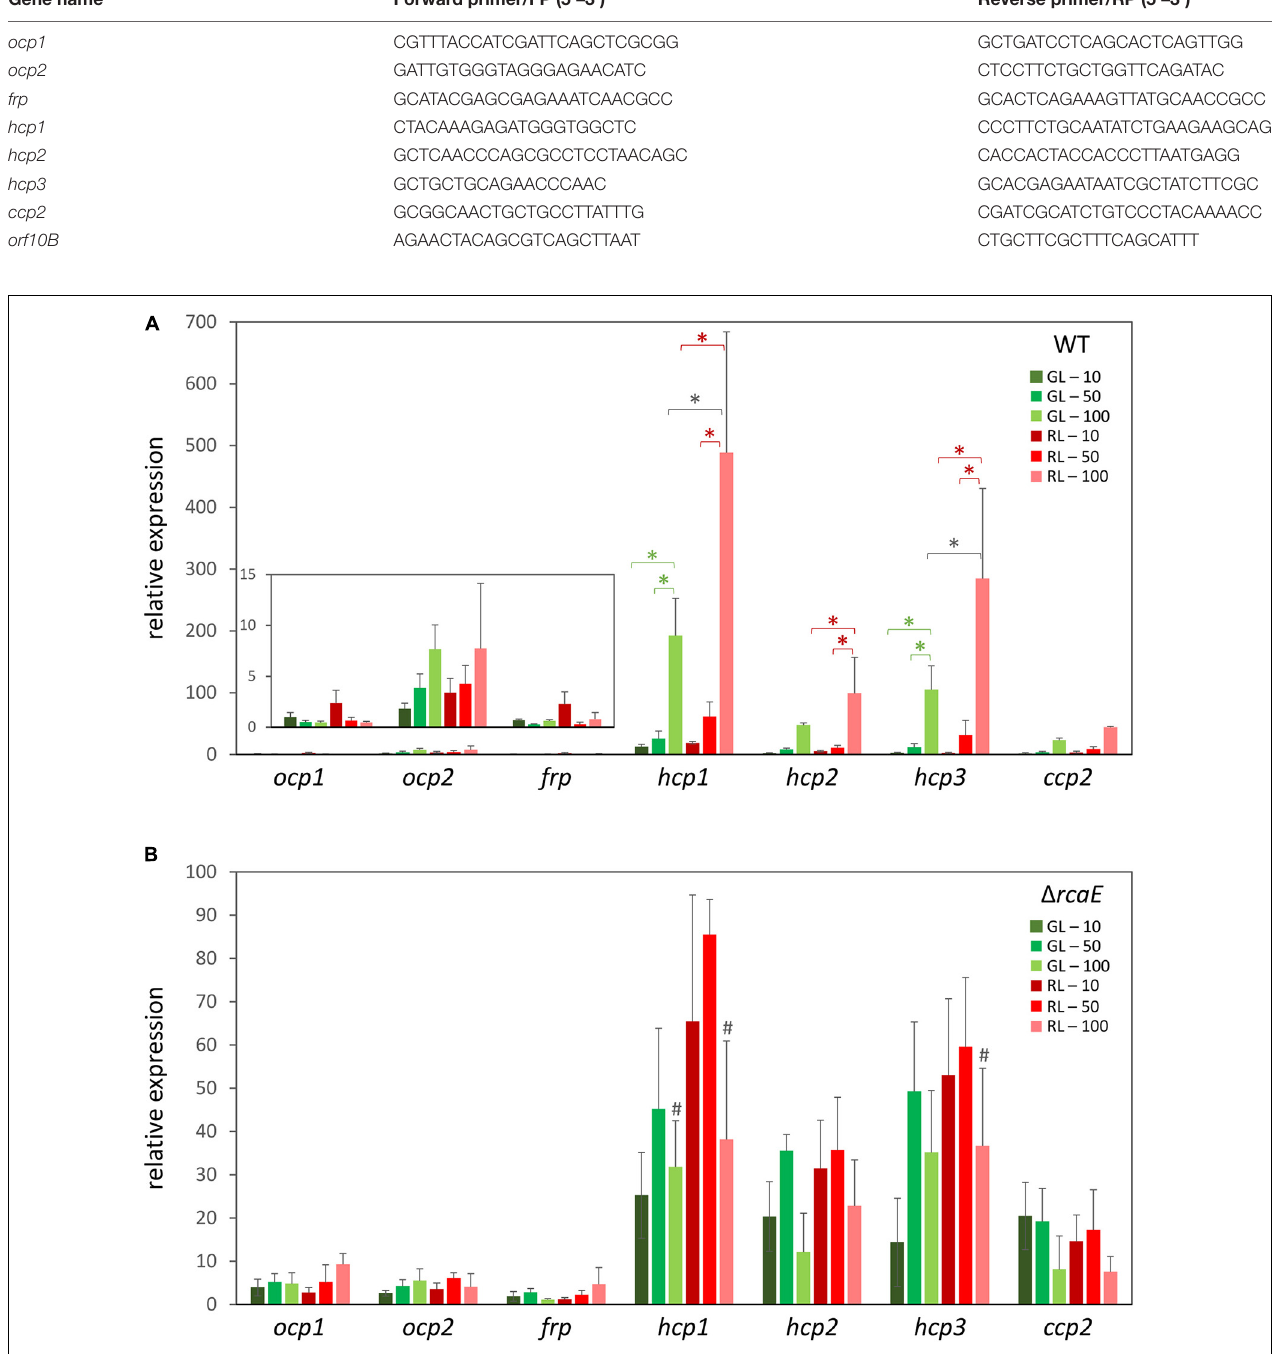
FIGURE 1 | Expression of orange carotenoid protein ( ocp ) homologs under varying light conditions. Cultures of wild type (A) and (cid:49) rcaE (B) Fremyella diplosiphon were grown under green light (GL) and red light (RL) at light intensities of 10 (dark green and dark red), 50 (green and red), and 100 (light green and light red) µ mol m − 2 s − 1 . Relative expression of ocp1 , ocp2 , frp , hcp1 , hcp2 , hcp3 , and ccp2 were measured using quantitative real-time PCR (qPCR). Expression under each condition is shown relative to expression under 10 µ mol m − 2 s − 1 of green light. Error bars represent the standard deviation of each measurement. ∗ p < 0.05, with dark gray stars indicating a difference for a strain in GL compared to RL at a specific light intensity, and red or green stars indicating a difference between different intensities of RL or GL, respectively; # p < 0.05 representing a difference between WT and (cid:49) rcaE in identical light conditions as determined by a ANOVA with Tukey-Kramer HSD post hoc